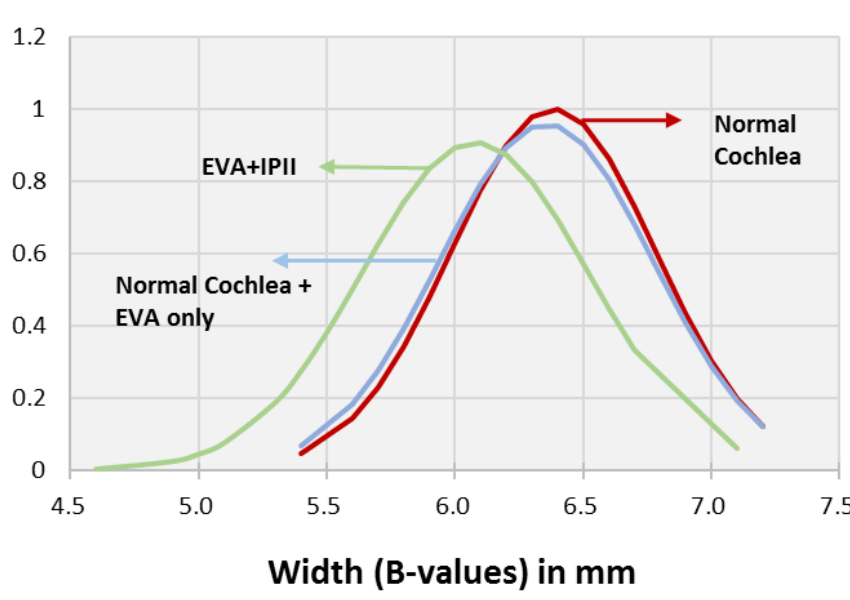
Figure 3. Bell curve (normal distribution curve) of the B value comparing the groups with normal cochleae, normal cochleae + EVA only, and EVA + IP II.